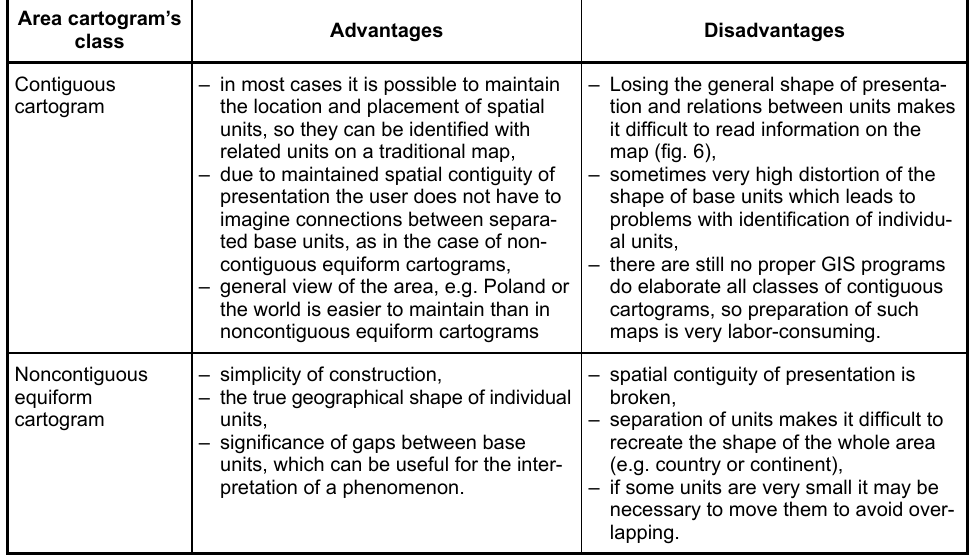
Table 1. Advantages and disadvantages of contiguous and noncontiguous area cartograms (B.D. Dent et al. 2009) Area cartogram’s